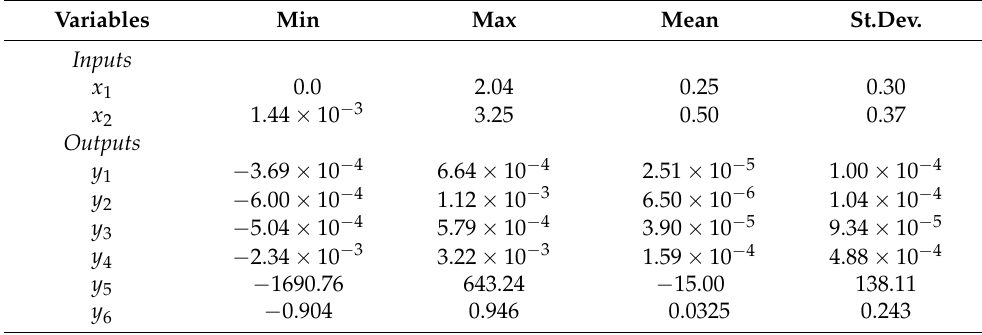
Table 2. Dataset statistics.